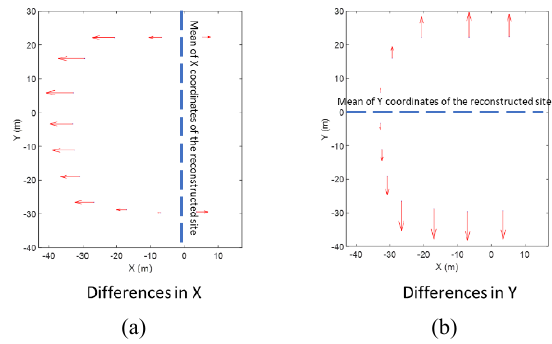
Figure 8. Differences in (a) X coordinates and (b) Y coordinates shown by red arrows between image-derived and RTK-GNSS coordinates of the twelve ground targets for A-1 dataset where blue lines represent mean of X and Y coordinates of the reconstructed site (magnitude of the arrows is magnified by a factor of